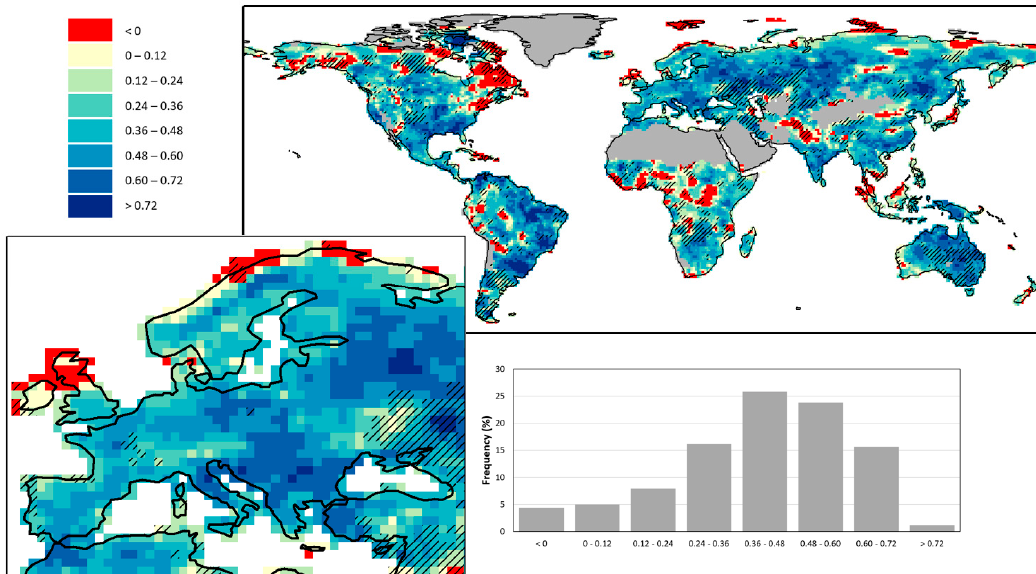
Figure 6. Spatial distribution of the R values corresponding to the relationship between SPI-12 and TWSA (main panel). The striped cells are those where there was a statistically significant difference ( p ≤ 0.05) between the local-optimal (see Figure 3) and the SPI-12 R values. The map in the lower-left corner highlights the outcomes over Europe, whereas the lower-right panel shows the frequency distribution of the R values over Europe.